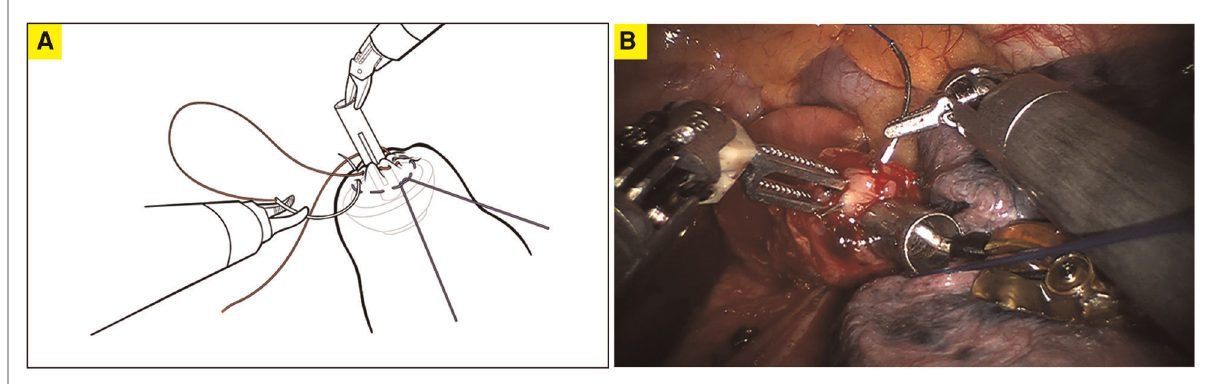
FIGURE 3 The super fi cial second purse-string suture of the full-layer of the proximal esophageal stump; A . diagram illustrating the second robotically sewn purse-string suture; B . surgical picture of the second robotically sewn purse-string